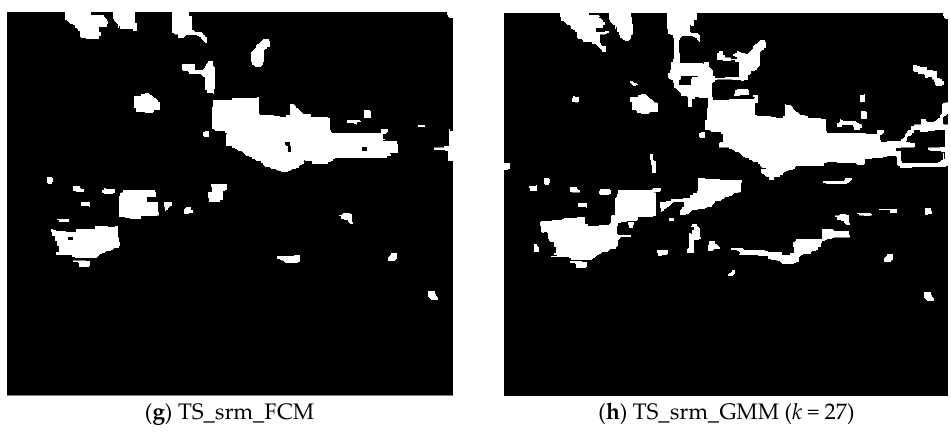
Figure 10. Change detection results of the different algorithms over YanDong Lake.